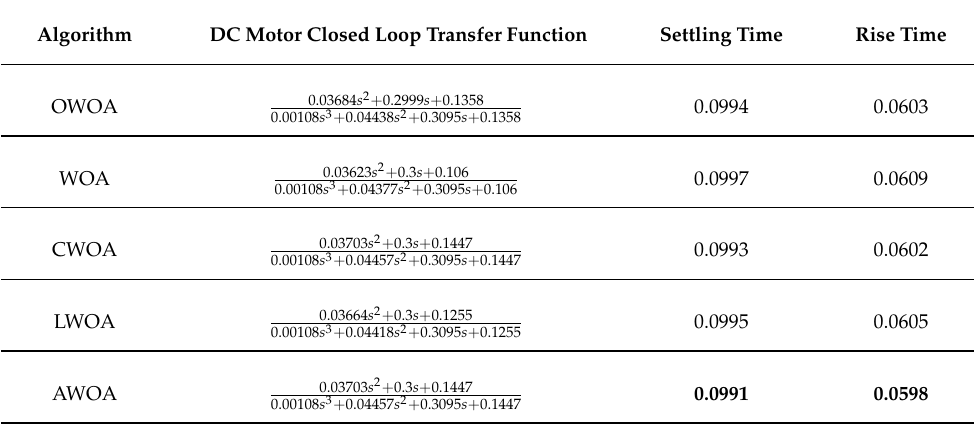
Table 13. Comparison of AWOA with other algorithms for the DC motor controller design problem.